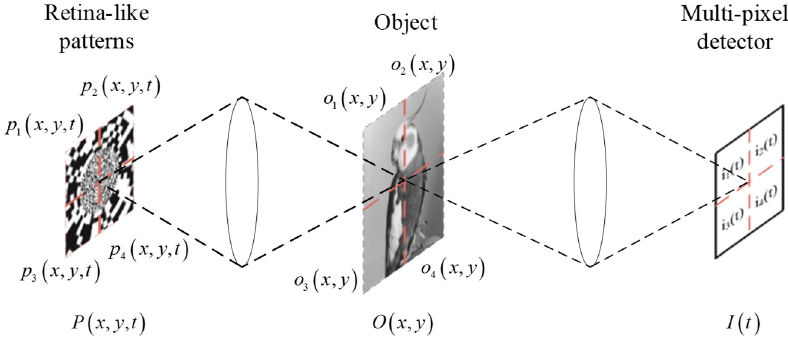
Figure 2. Measurement principle of the PRGI.